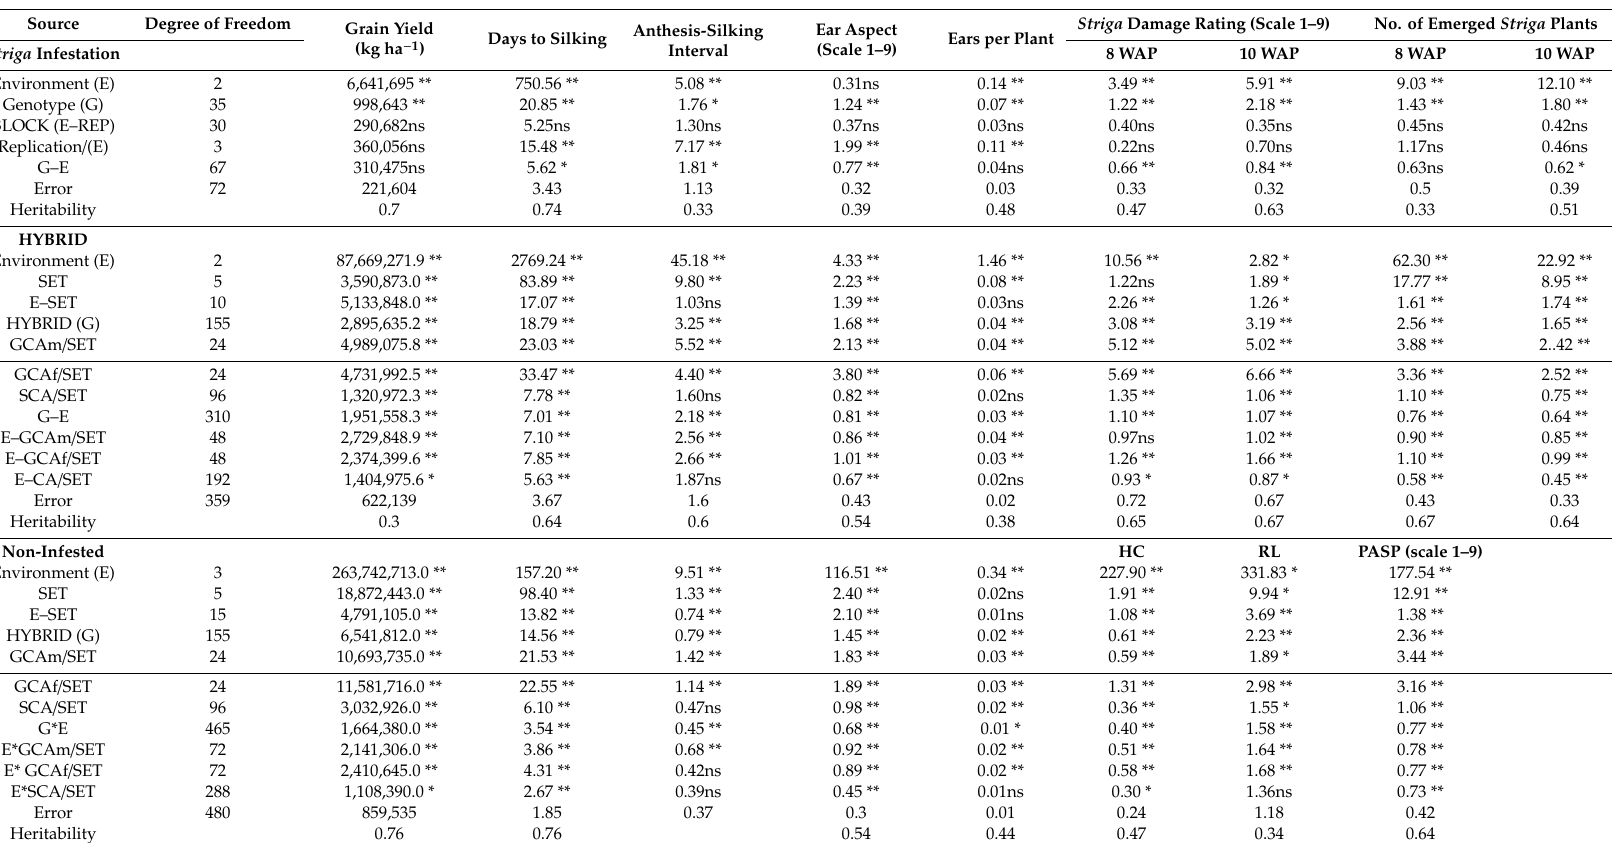
Table 1. Mean squares of grain yield and other agronomically important traits of 36 early maturing white maize inbred lines and 156 hybrids screened under artificial Striga infestation and non-infested environments in Nigeria during 2014 and 2015 crop